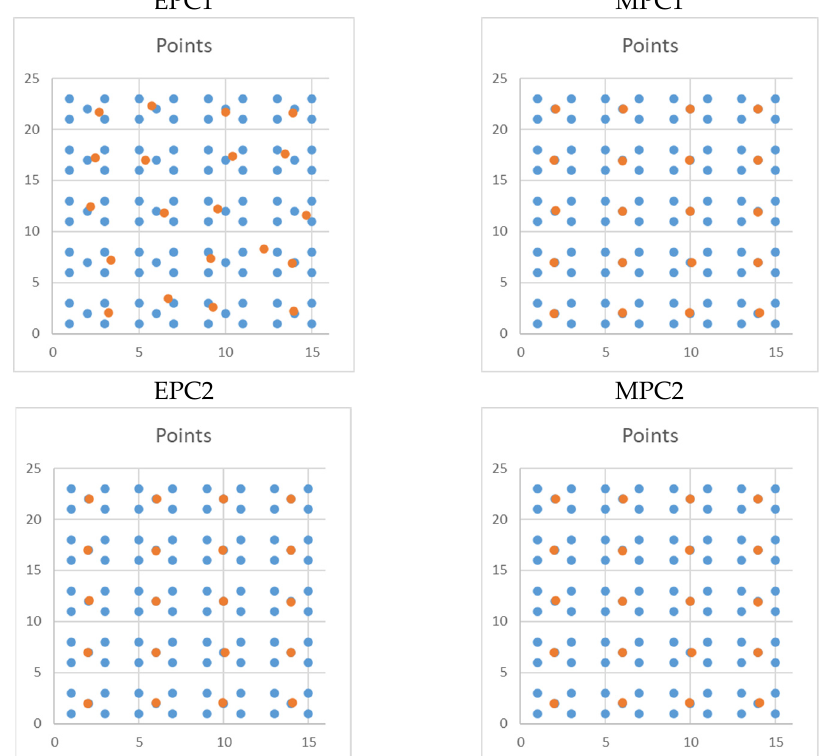
Figure 5. Best solution found by different methods using different hardware configurations.